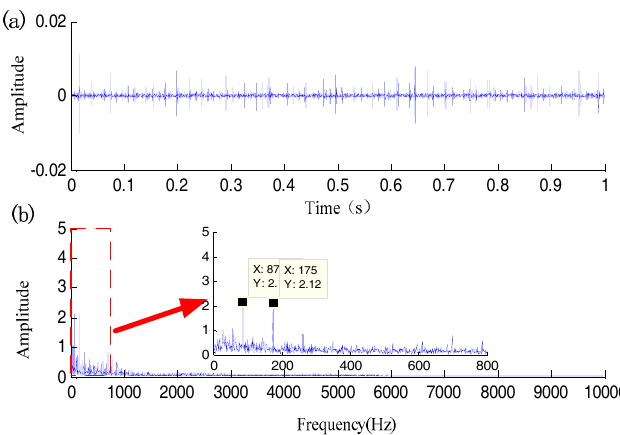
Figure 12. Time domain waveform and Hilbert envelope demodulation spectrum of the detail signal with the maximum kurtosis value. ( a ) The waveform of the detail signal with the maximum kurtosis value. ( b ) The Hilbert envelope demodulation spectrum of the detail signal with the maximum kurtosis value.